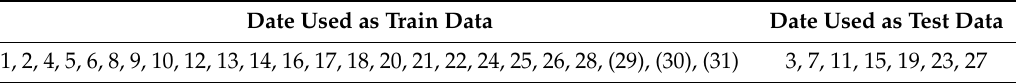
Table 6. Train and test data split in each month.